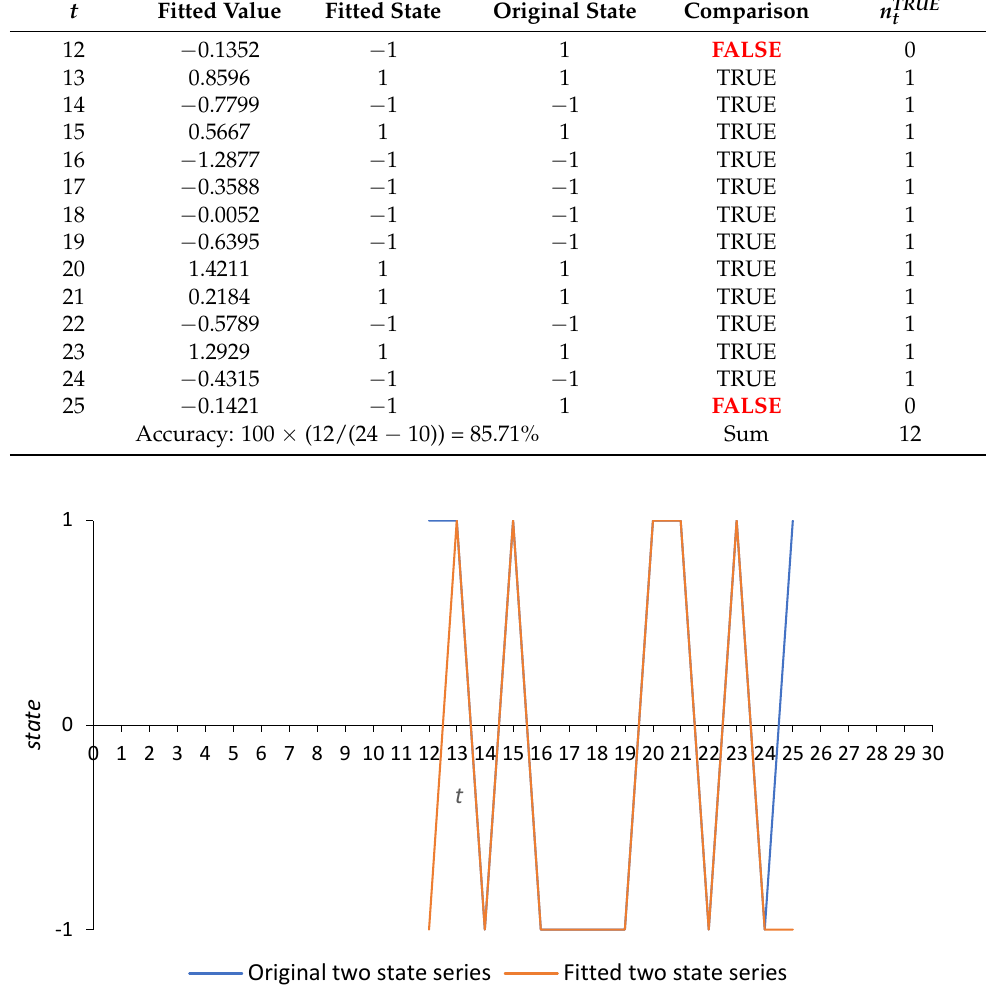
Table 20. Fi tt ed series with corresponding states, and model accuracy for M4 x –the fi rst di ff erence.